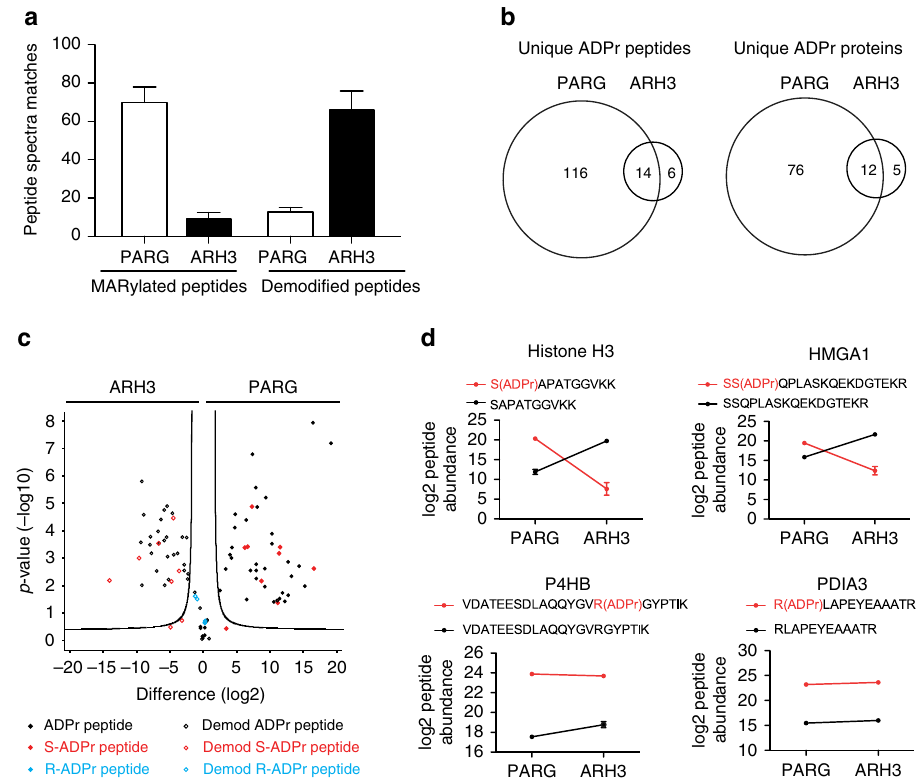
Fig. 2 ARH3 mainly hydrolyzes ADP-ribosylated serines in vitro. a Number of ADP-ribosylated peptide spectra matches (PSMs) or demodi fi ed peptide spectra matches after PARG or ARH3 treatment. Data represent means ± SEM for n = 3 independent demodi fi cation experiments. b Venn diagrams of unique ADPr peptides and proteins. c Volcano plot of ARH3- and PARG-treated samples. “ Unmodi fi ed peptides ” are shown as open circles and “ ADP- ribosylated peptides ” as fi lled circles. ADP-ribosylation sites con fi rmed by EThcD spectra are annotated and color coded in red as S-ADPr and in blue as R- ADPr sites. ADP-ribosylated peptides with uncertain ADP-ribosylation site localization are shown in black. The black hyperbolic line represents a permutation-based false discovery rate (FDR) of 5% and a minimal fold change of 2. d Normalized abundance of individual Ser- and Arg-ADPr peptides after PARG or ARH3 treatment. Data represent means ± SEM for n = 3 independent demodi fi cation